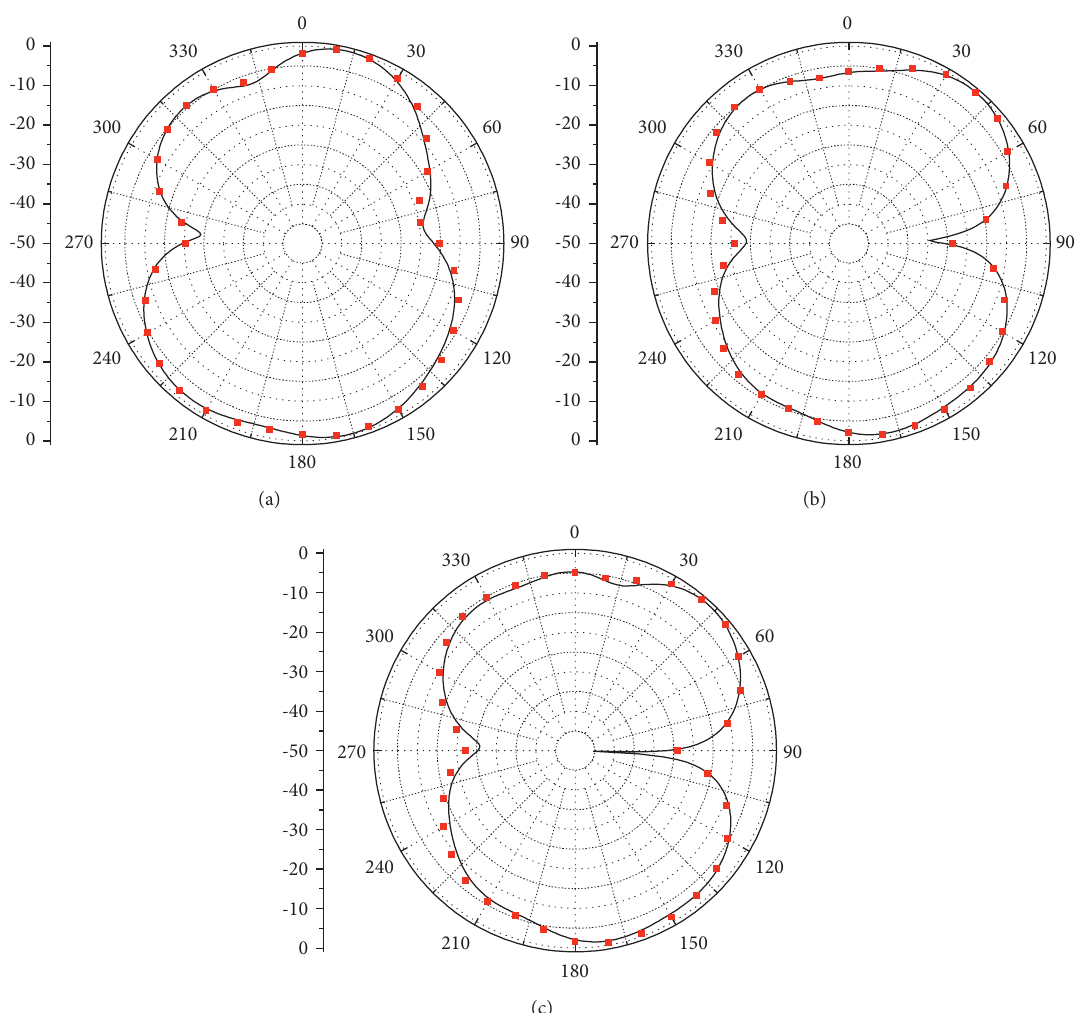
Figure 10: Simulated and measured radiation characteristics of the proposed array for the yz -plane at (a) 23GHz, (b) 28GHz, and (c) 29GHz ( − simulated and ▀